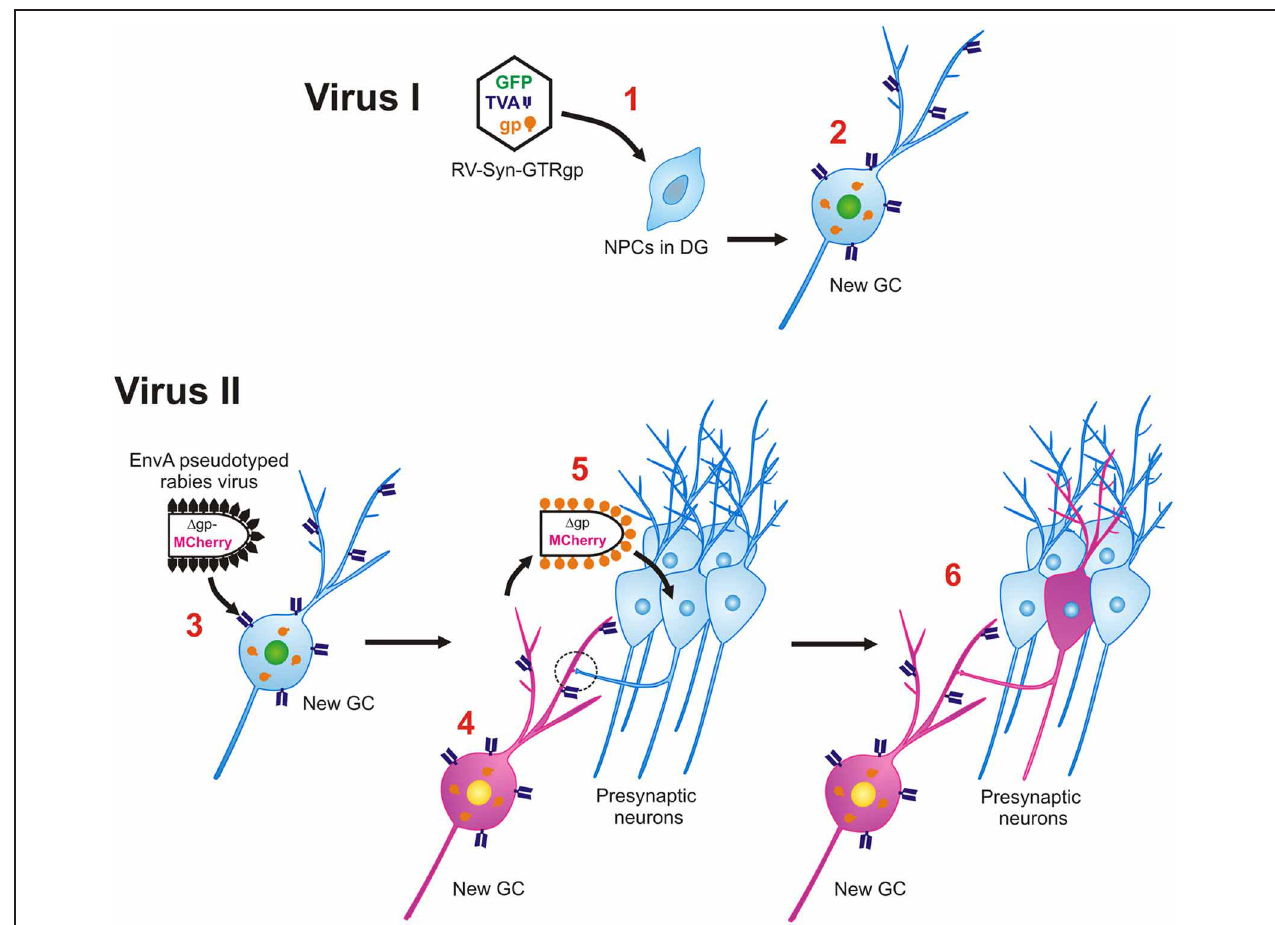
FIGURE 3 | Monosynaptic retrograde tracing of inputs to new GCs. Virus I, Retroviral labeling. 1 . Retrovirus (RV-SYN-GTRgp) expressing nucleus-localized histone-tagged green fluorescent protein (hGFP), avian TVA receptor, and rabies glycoprotein (gp) under control of the synapsin promoter infect proliferating neural progenitor cells (NPCs) in the DG. 2 . The retrovirally labeled NPCs differentiate into newborn GCs over time and express hGFP, TVA and gp. Virus II, Rabies virus. 3 . Avian envelope glycoprotein EnvA pseudotyped rabies virus, in which rabies gp was replaced with MCherry (EnvA- (cid:2) G-MCh) is injected into the same